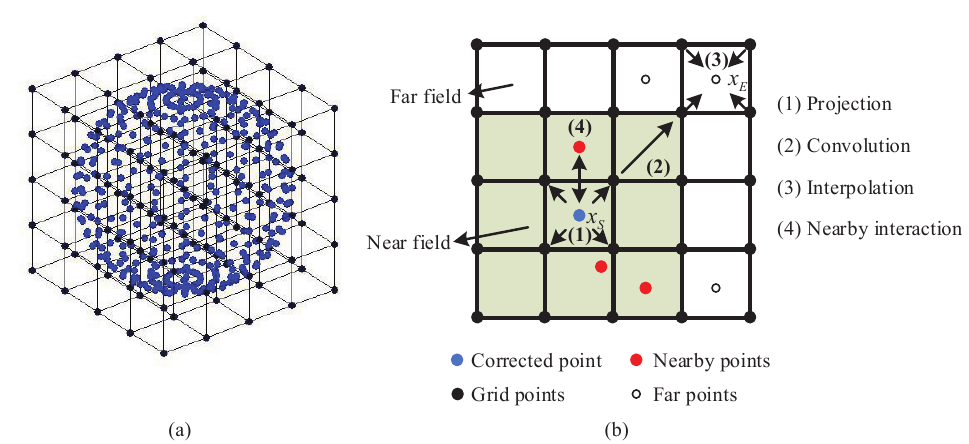
Figure 1. The pFFT algorithm: ( a ) construction of the 3D uniform grid; ( b ) the four steps: 2D pictorial